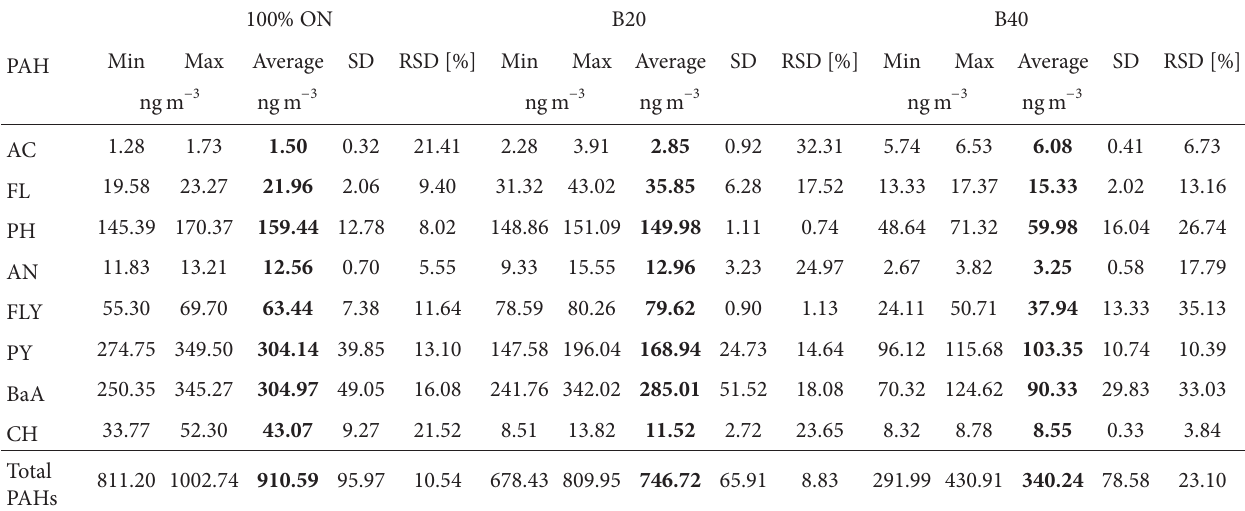
T 4: Results of quantitative PAH analysis in particles fraction of